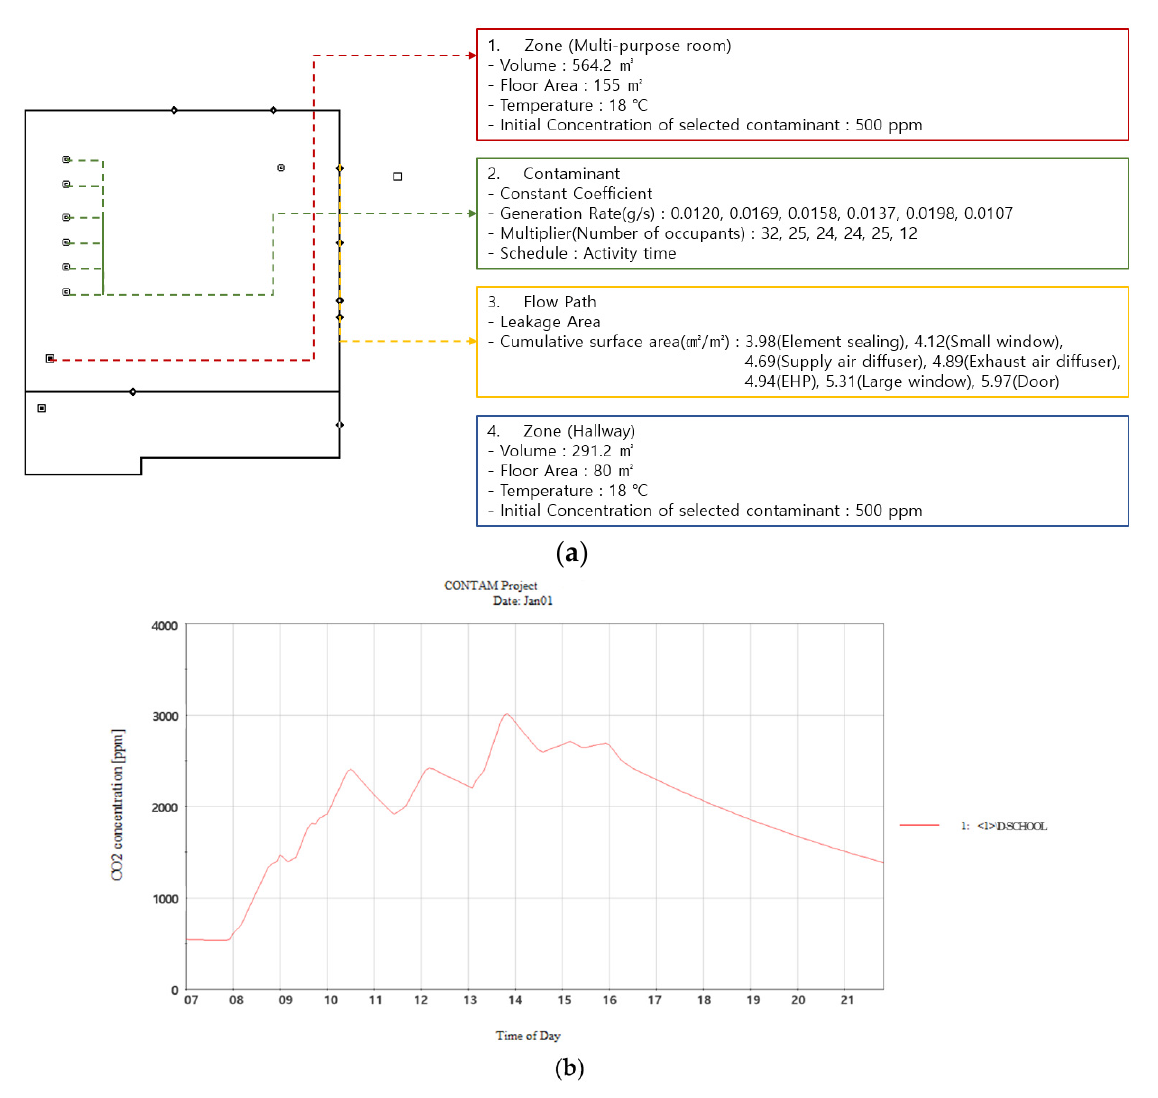
Figure 6. ( a ) Zone, pollutants, flow path, and corridor input conditions for the CONTAM simulation; ( b ) CONTAM simulation result of CO 2